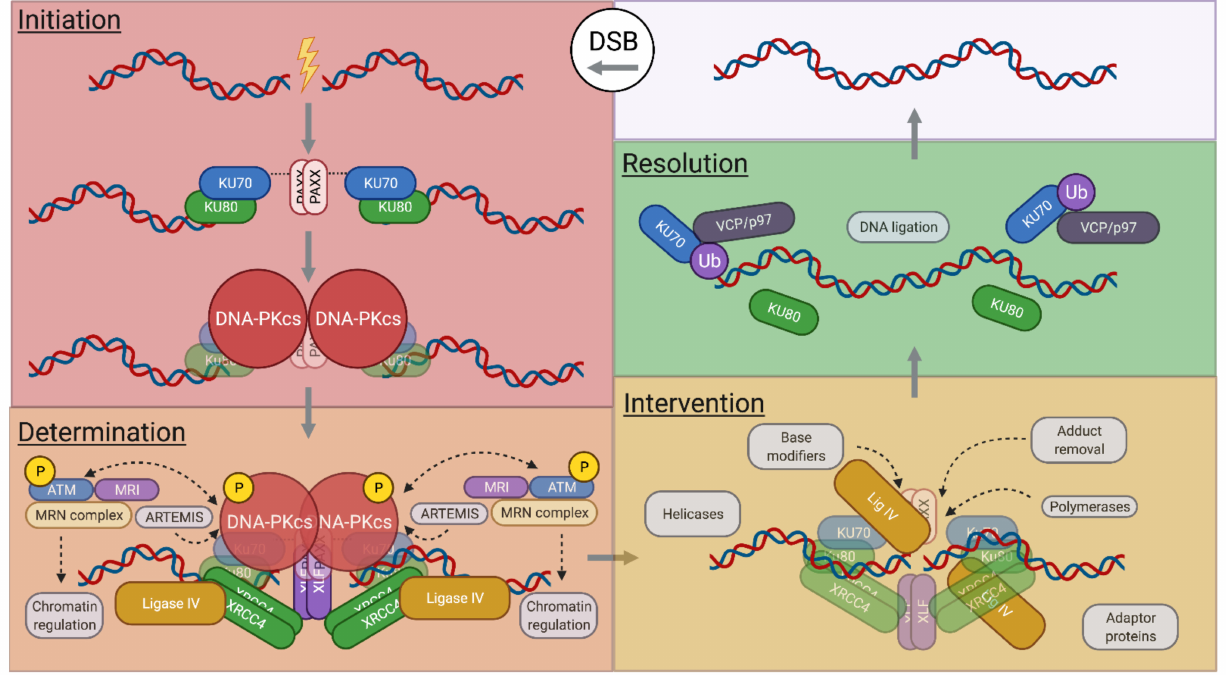
Figure 1. Four phases of DSB repair by NHEJ. Initiation: the NHEJ DSB sensing complex, Ku, recognizes and binds DSEs. PAXX dimers may keep DSEs paired by interaction with KU70. DNA-PKcs binds to Ku to form DNA-PK. Determination: DNA-PK is phosphorylated by ATM and vice versa; MRI mediates their interaction but no clear mechanism beyond binding. ATM and the MRN complex mediate chromatin remodeling of the neighboring chromatin to prime for repair pathway commitment. Phosphorylated DNA-PK activates ARTEMIS to open DNA hairpins and suppress DNA ligation during this process. Binding of XLF, XRCC4 and Ligase IV induces conformation changes to strengthen synapsis of paired DSEs. Intervention: hyper trans autophosphorylation induces release of DNA-PKcs and engagement for end compatibility using a toolkit of end-processing enzymes. Resolution: DSEs are ligated and constitutive damage signal dissolves as ubiquitinated Ku is removed from DNA by the ATPase